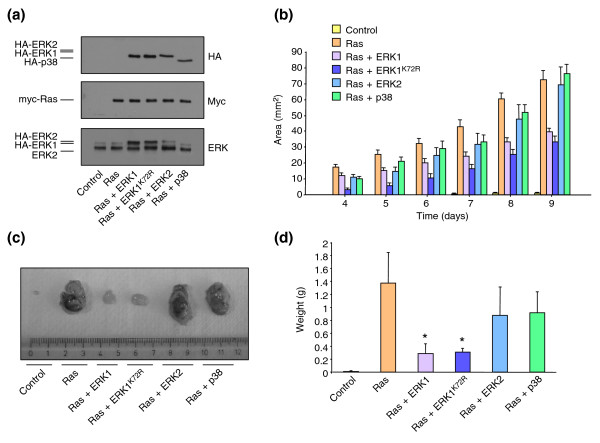
ERK1 expression inhibits Ras-dependent tumor formation in nude mice. (a) NIH 3T3 clones were transfected as indicated and expression of the relevant transgenes assessed by western blotting. (b) Growth of tumors in injected nude mice was monitored over 6 days starting from day 4 after injection, by determining the skin area covered by the tumor mass (mm2). The data are expressed as mean ± SEM of two independent experiments (ten animals per clone). (c) Representative tumors after sacrifice at day 10 are shown. (d) Mean weight (± SEM) of the different tumor samples is indicated. Asterisk indicates a genotype effect significant at p < 0.001, calculated using a post-hoc comparison in one-way ANOVA (Scheffe's test: RasQ61L-ERK1 versus RasQ61L-pMex; RasQ61L-ERK1K72R versus RasQ61L-pMex).